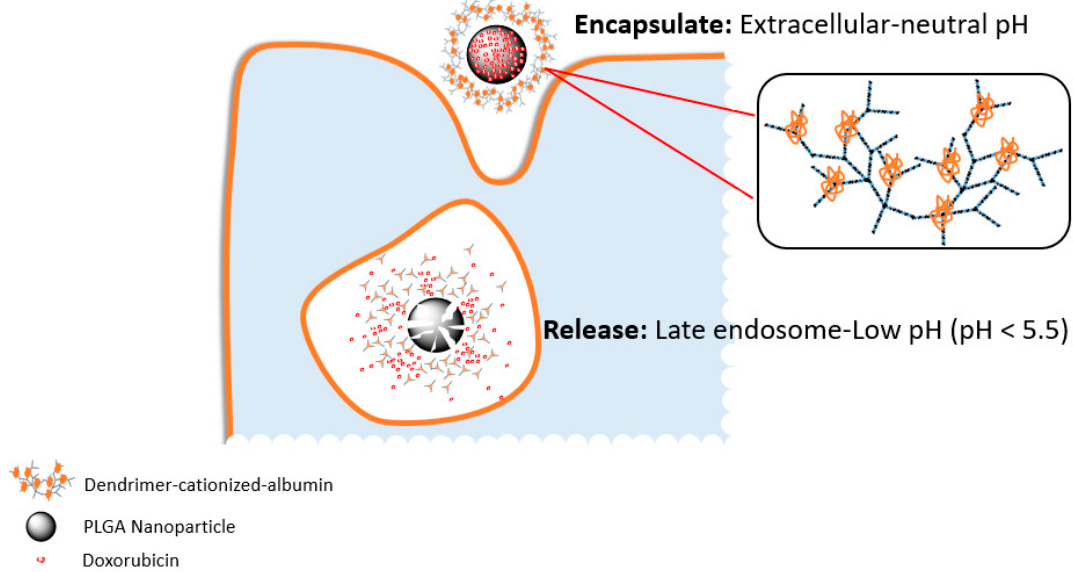
Figure 1. Graphic representation of the dissolution of dendrimer-cationized-albumin coated poly(lactic-co-glycolic-acid) (PLGA) nanoparticles. Doxorubicin (DOX) is released in the U-87 MG glioblastoma cells due to the pH of the acidic late endosomal compartment.